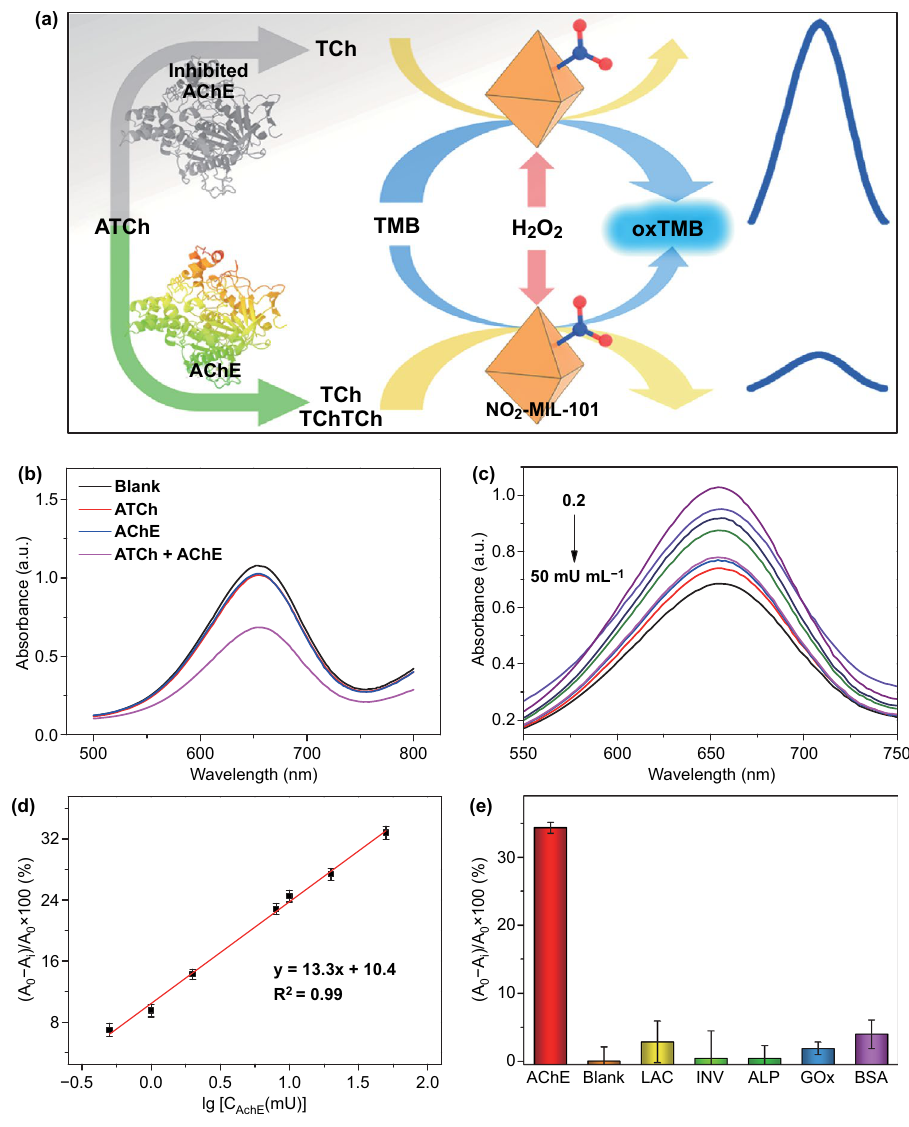
Fig. 4 a Schematic illustration of detecting AChE activity using a NO 2 -MIL-101-based biosensor. b Absorption spectra of ATCh, AChE and ATCh + AChE in the NO 2 -MIL-101-based biosensor. c Absorption spectra of NO 2 -MIL-101-based biosensor in the presence of differ- ent AChE concentrations. d A linear relationship between the AChE activity and the variation of absorbance at 652 nm. e Selectivity test of